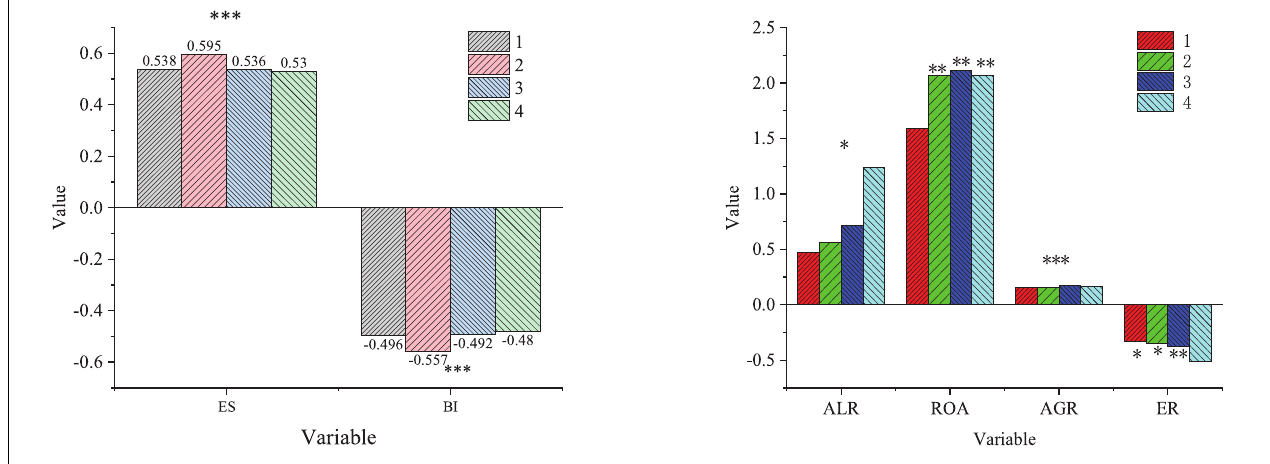
FIGURE 3 | Results of logit model regression ( ∗∗∗ , ∗∗ , and ∗ represents significance at the levels of 0.01, 0.05, and 0.1, respectively).